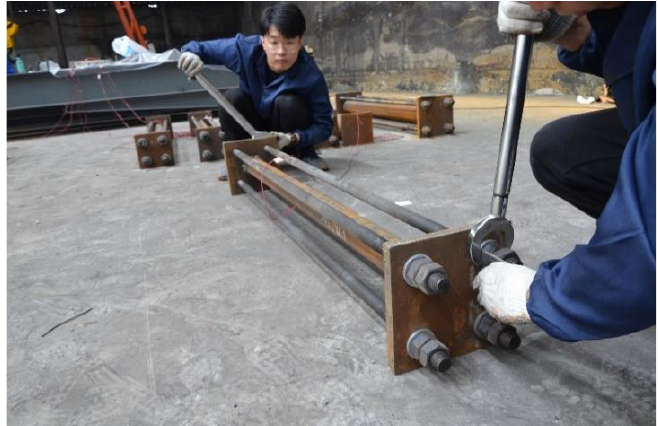
Figure 4. Preload applying.